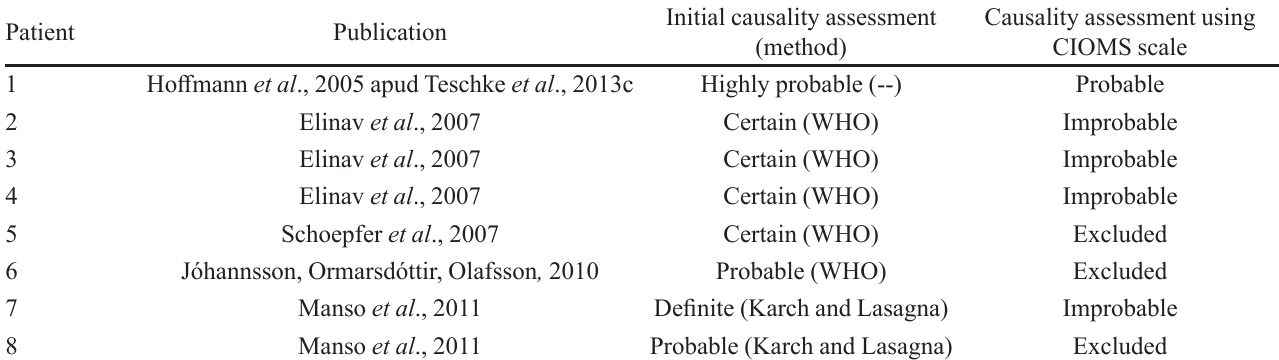
TABLE III - Comparison of initial causality assessment results with causality assessment results using the CIOMS scale (Teschke et al. ,